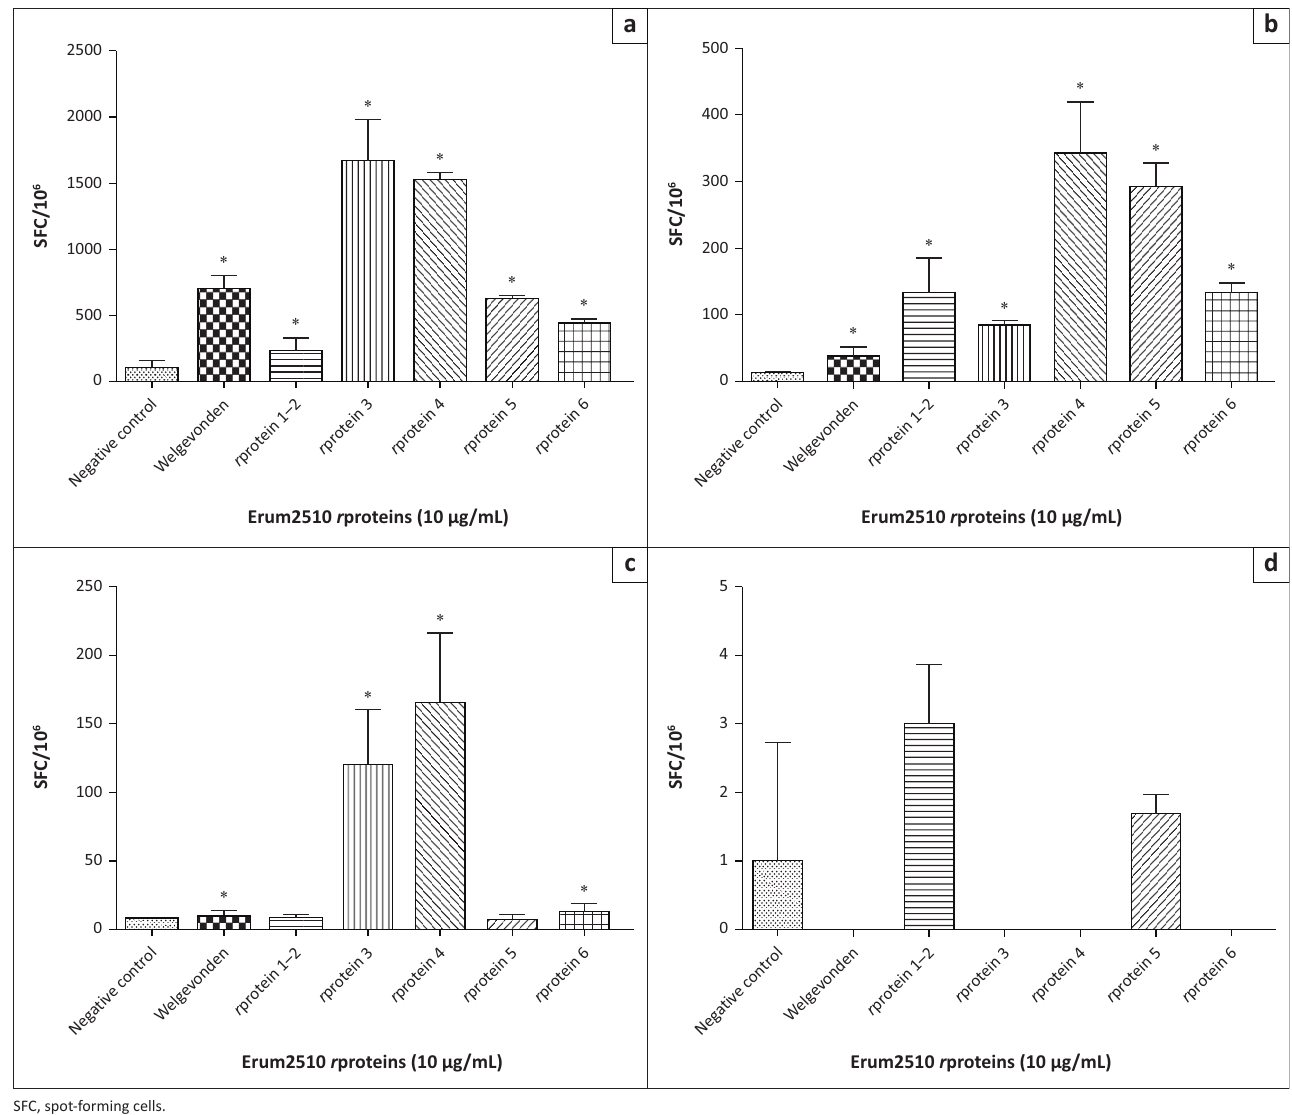
FIGURE 1: Secretion of interferon gamma (IFN- γ ) (a, b) and interleukin 4 (IL-4) (c, d) by immune peripheral blood mononuclear cells (PBMC) from s6823 (a, c) and sM2 (b, d) stimulated with Erum2510 r proteins and crude Welgevonden-strain antigen (positive control) and unstimulated PBMC (negative control). Data are presented as the average number of spot-forming cells per